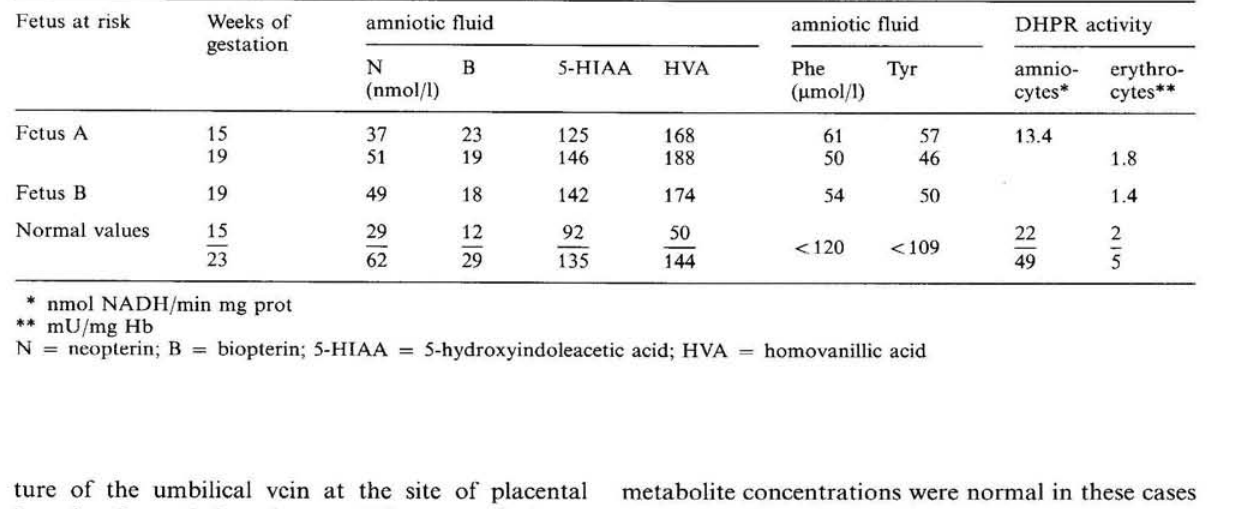
Table 1. Pterins, neurotransmitter metabolites and amino acids in amniotic fluid, and DHPR activity in amniocytes and in fetal erythrocytes. Fetus at risk Weeks of amniotic fluid gestation